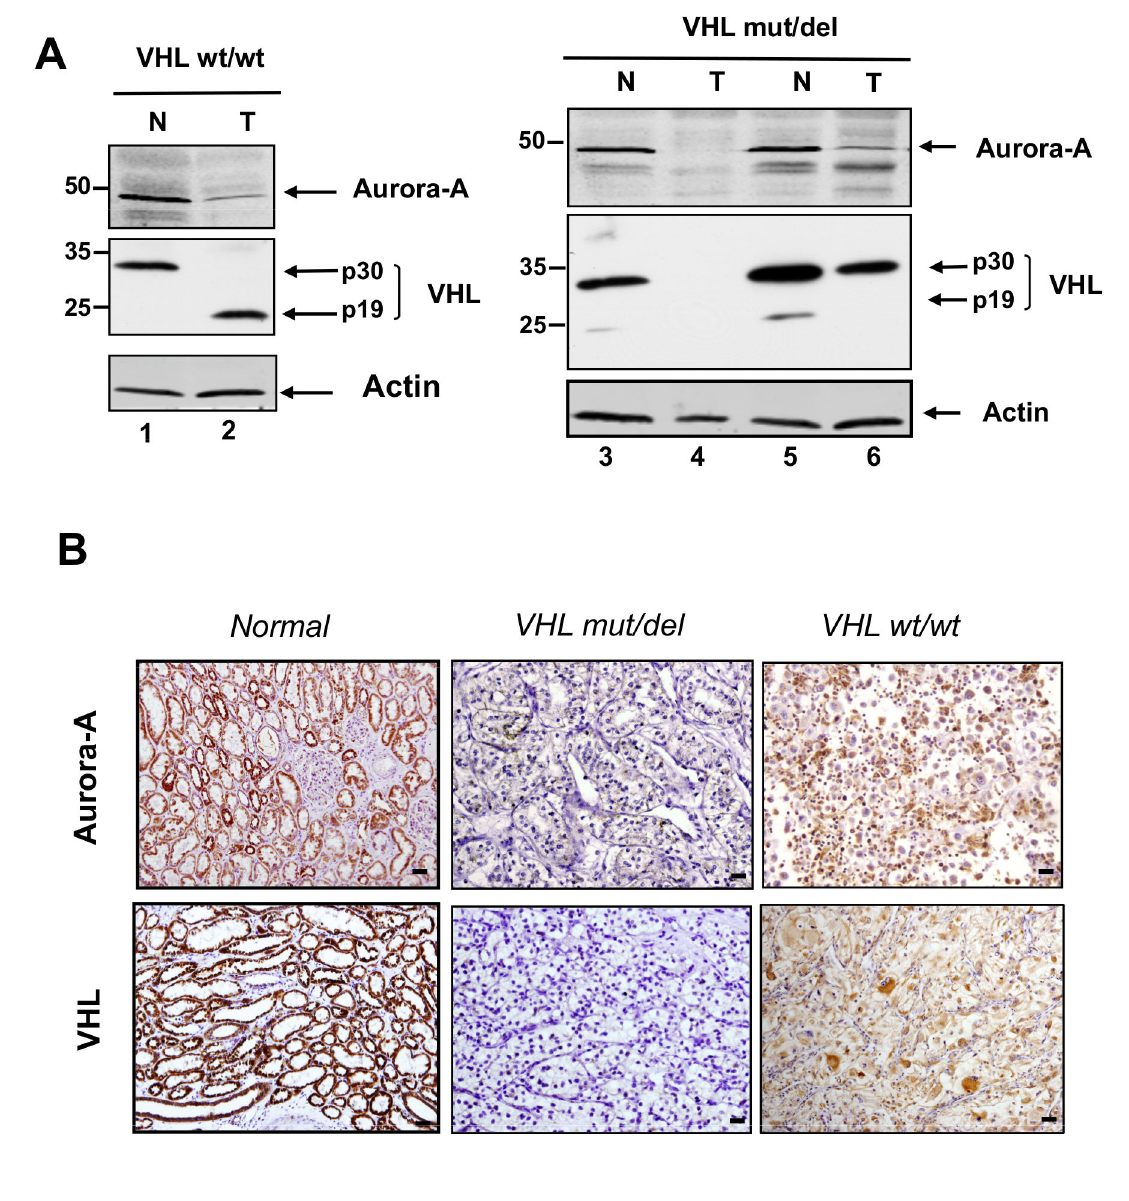
Figure 2. Detection of Aurora-A and VHL in healthy and tumour tissues. A-Western blot analysis of protein extracts from ccRCC and matching healthy tissue samples. Total proteins from tumour (T) and healthy (N) tissue samples were extracted using the RIPA buffer and analysed by western blotting with the anti-Aurora-A polyclonal antibody (1:200) and the anti-pVHL monoclonal antibody (1:500). β-actin was used as loading control. B-Immunohistochemical analysis of Aurora-A and VHL expression in ccRCC and matching healthy tissue samples. Tissues samples were prepared for immunohistochemistry as described in Materials and Methods and analysed using the polyclonal antibody against Aurora-A (1:100) and the monoclonal antibody against pVHL (1:200). Microphotographs were acquired with a Leica™ DMRXA microscope equipped with a CoolSnapsHQ camera (Photometrics™) (bar